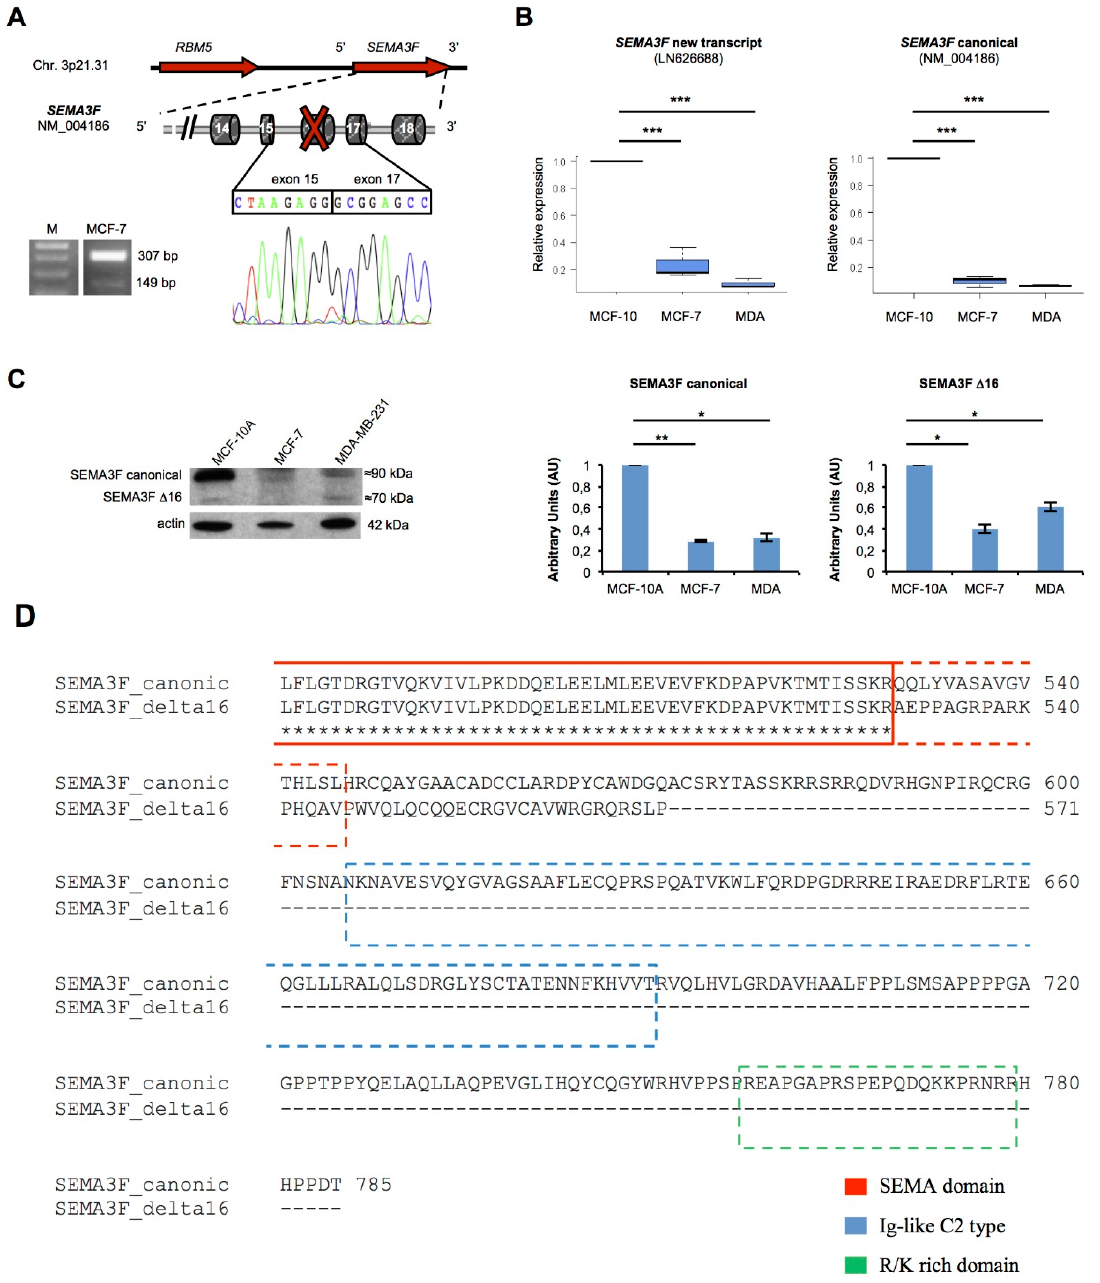
Figure 5. ( A ) Scheme of the new SEMA3F transcript and expression by RT-PCR on MCF-7 cell line, showing the canonical (307 bp) and the new alternative transcript (149 bp) of SEMA3F ; M is 100 bp DNA marker; ( B ) Boxplots with the relative expression of both annotated and new SEMA3F transcript in breast cell lines measured with qRT-PCR ( n = 3); ( C ) On the left , immunoreactive bands—corresponding to the canonical (about 90 kDa) and the new isoform (about 70 kDa) of semaphorin 3F—detected by Western Blot on whole breast cell lines lysates. On the right , the densitometry results (AU = Arbitrary Units) by ImageJ of the Western Blot bands, after normalization with actin, are shown as bar graphs ( n = 2); ( D ) A detail of the protein alignment of the canonical and the new semaphorin 3F protein isoform is shown. The dashed boxes represent the functional domains that are deleted in the novel protein sequence. Asterisks indicate significant p values (* p < 0.05; ** p < 0.01; *** p < 0.001).